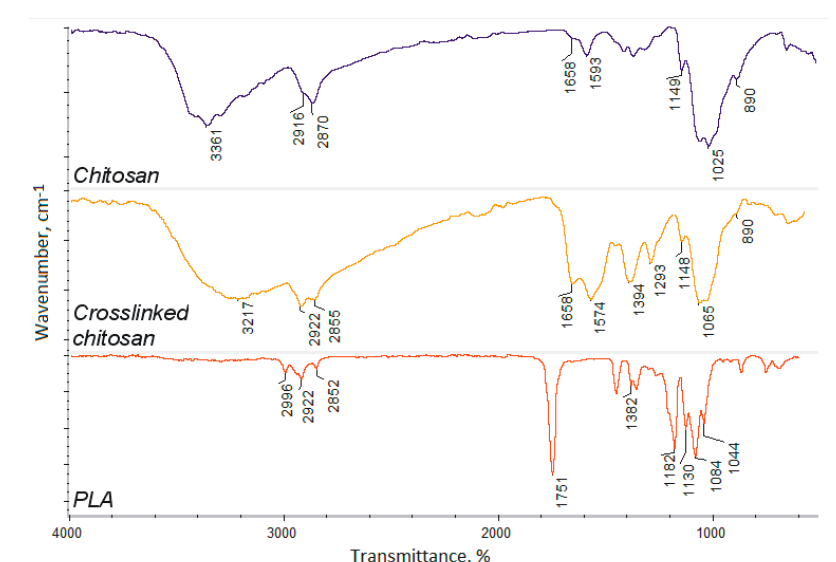
Figure 1. The general 3D scaffolds’ obtainment strategy and application.